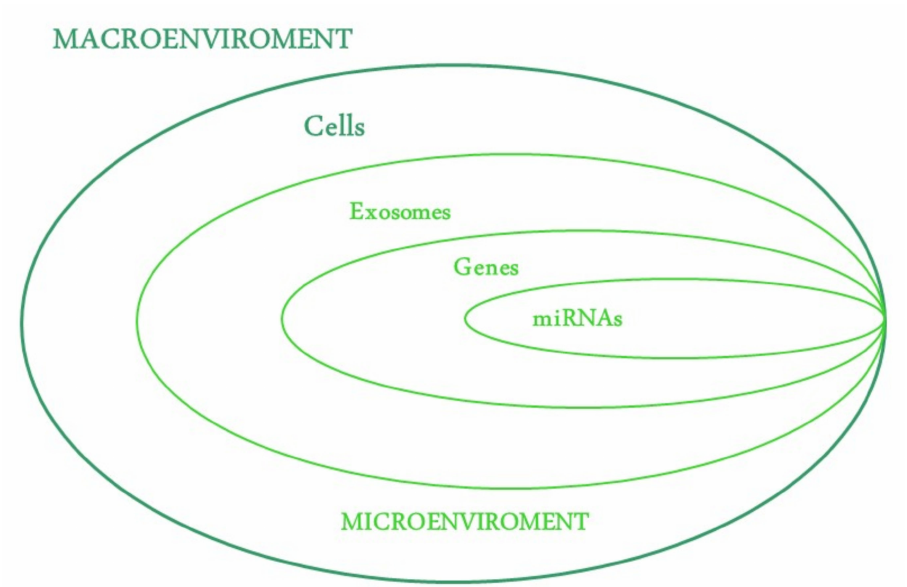
Figure 1. Targets of Regenerative Ophthalmology: The diagram illustrates the main targets of regenerative therapies: cells, as a complex macroscopic unit, and the microscopic constituents embedded within